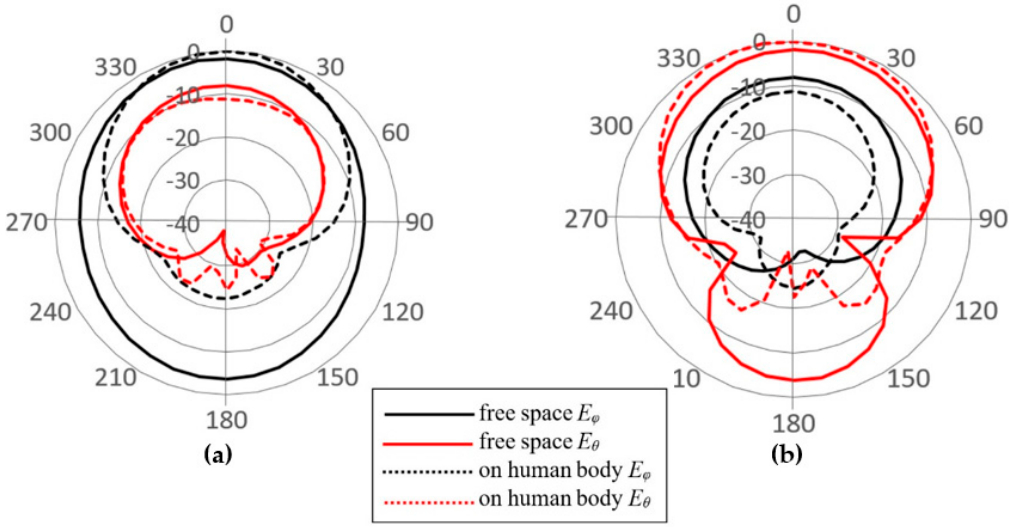
Figure 16. Radiation patterns of P-fed I-shape MSA at 2.45 GHz for antenna in the free space (solid) and on human body (dashed). ( a ) xz plane; ( b ) yz plane.